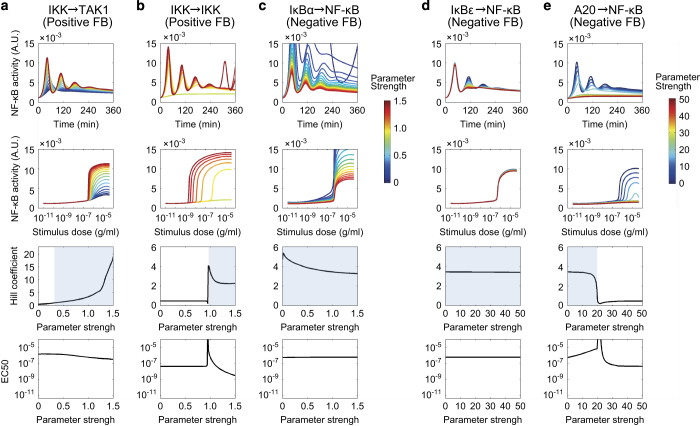
Individual effects of feedback loops in nuclear factor kappa B (NF-κB) dynamics. Time course (upper panels), antigen dose response (second panels), Hill coefficient (third panels) and EC50 (bottom panels) of NF-κB activity in response to changes in reaction rate of the feedback (FB) loop; (a) Positive feedback loop from IKKβ to TAK1 (49, kTpCIKK3). (b) Auto-positive feedback loop in IKKβ (76, kIpCfaIKKppC). (c) Negative feedback loop mediated by NF-κB-induced IκBα expression (141, kprodmrnaikba). (d) Negative feedback loop mediated by NF-κB-induced IκBε expression (152, kprodmrnaikbe). (e) Negative feedback loop mediated by NF-κB-induced A20 expression (158, kprodmrnaa20). Parameter strength is shown as fold-change values in color (high; red, low; blue) compared with the original parameter value (Supplementary Table 1). For the Hill coefficient, parameters showing switch-like response (Hill coefficient >1) are in blue. Numbers and kinetic rate constants shown in brackets above indicate reaction indices and changed parameters in Supplementary Figure 1 and Supplementary Table 1, respectively.